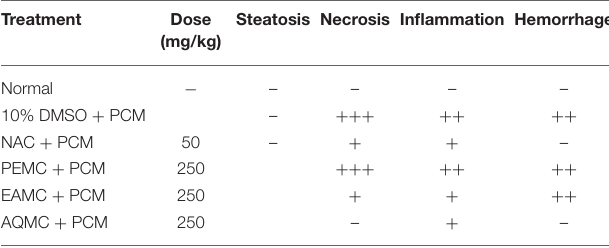
TABLE 3 | Histopathological scoring of PCM-intoxicated rat’s liver tissue following pretreatment with PEMC, EAMC, or AQMC at the dose of 250 mg/kg. Treatment